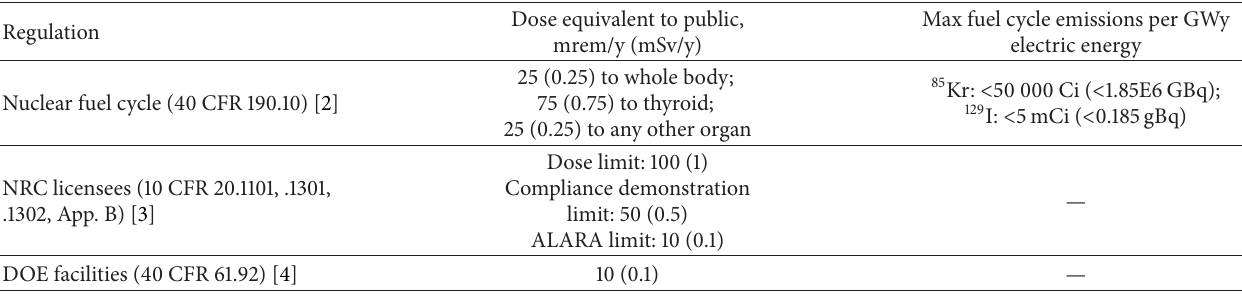
Table 1: The US radionuclide air emission regulations.